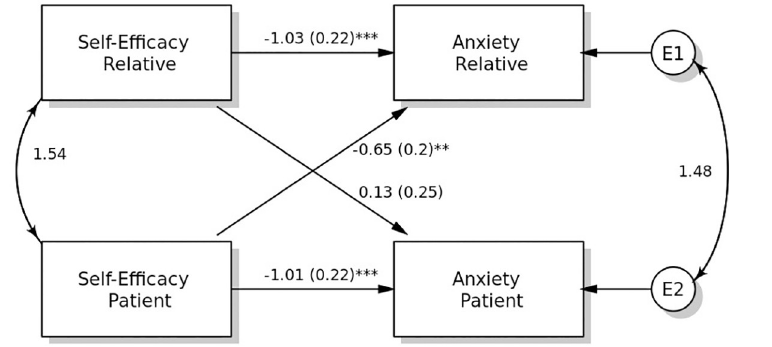
Fig 2. The standard model for self-efficacy on